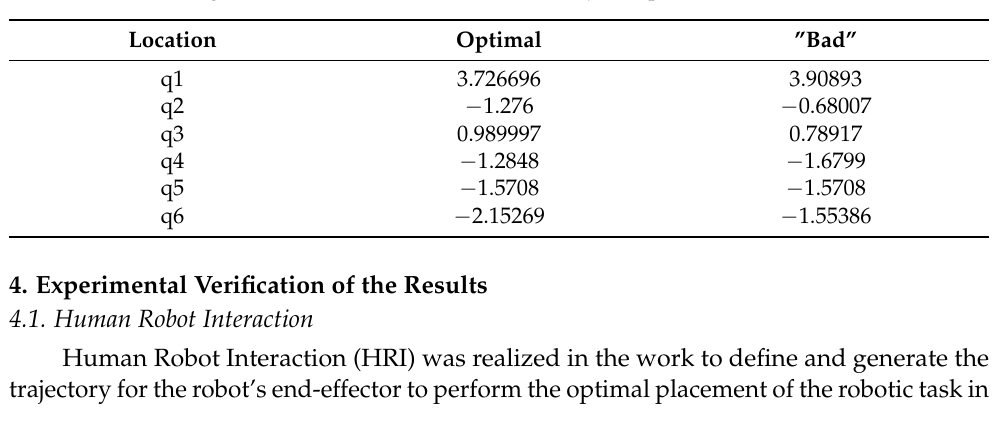
Table 2. Path starting frame { L } locations as derived in the joint space (in rad).